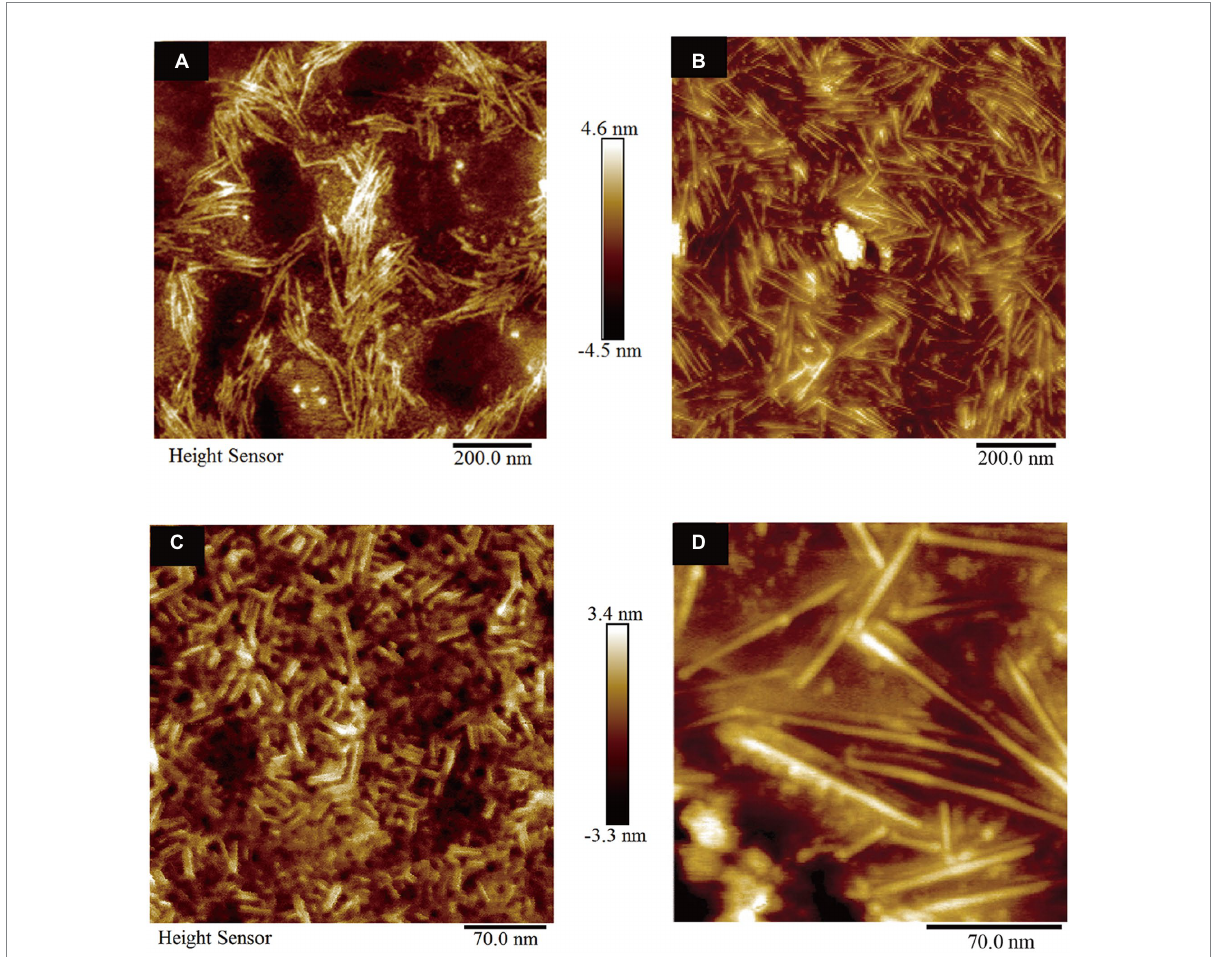
FIGURE 7 Surface morphology observation of hydrophobin-modified mica ( n = 3). (A) AFM image of mica coated with HGFI-His. (B) AFM image of HGFI- coated mica. (C) AFM image of HGFII-coated mica. (D) AFM image of HGFI-coated mica. Images (B,D) , refer to our previous study (Yu et al.,